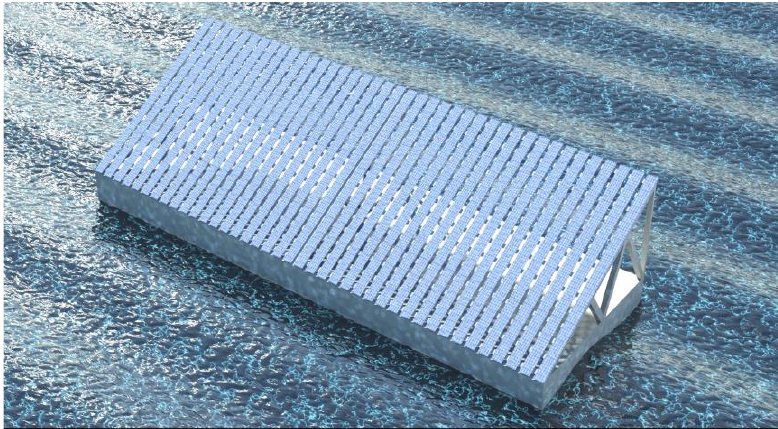
Figure 1. Pontoon-type floating structure supporting arrays of photovoltaic panels